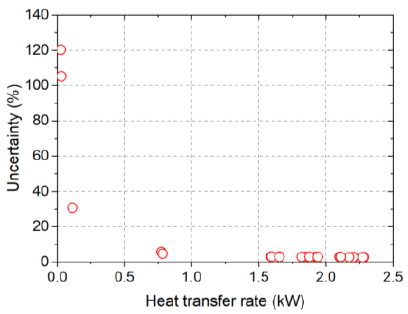
Figure 7. Maximum measurement uncertainty as a function of the heat transfer rate.